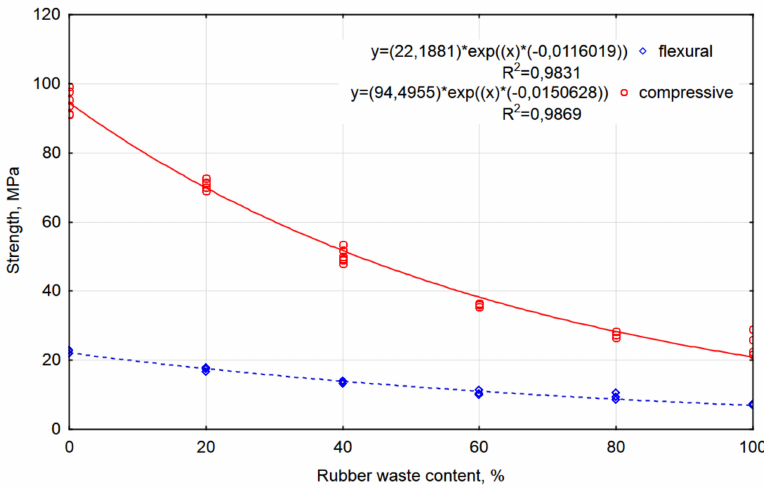
Figure 4. Graphs of functions describing the dependence of flexural and compressive strength on the percentage share of waste in the